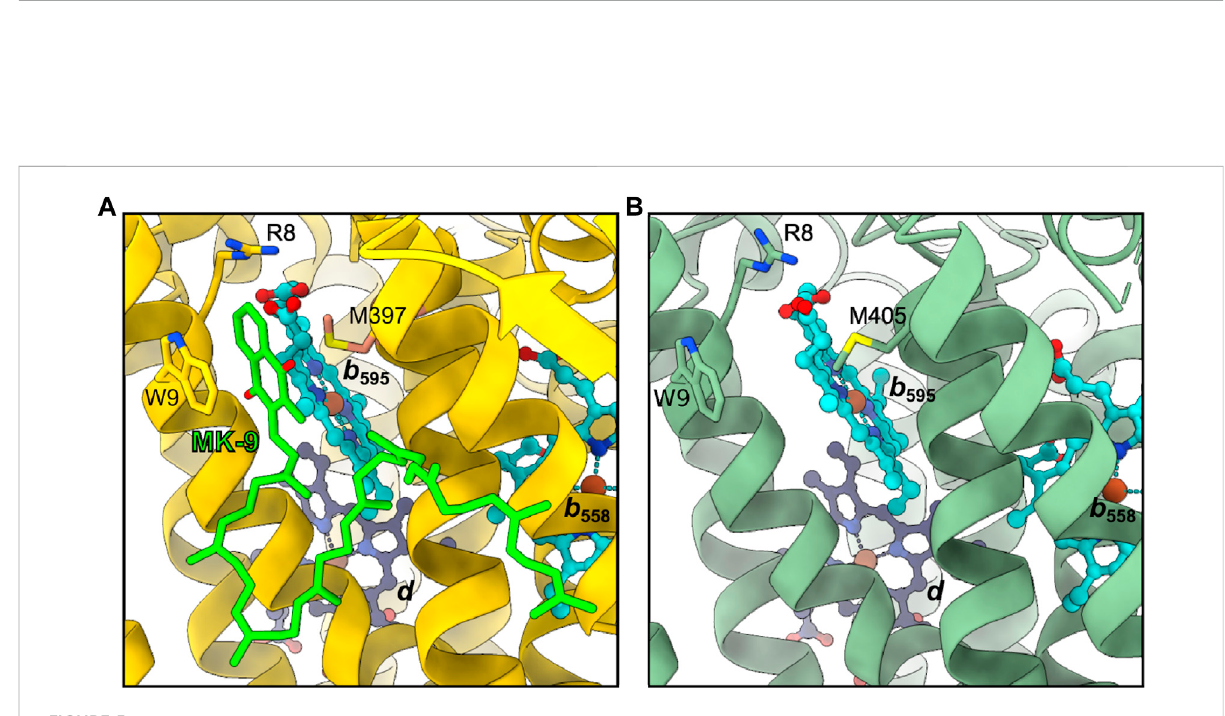
FIGURE 5 Second quinol binding site. (A) In Mtbd , site 2 harbors a bound MK-9 molecule stabilized by W9, R8 and M397. (B) Site 2 appears unoccupied in Cgbd , however the residues interacting with MK-9 in Mtbd are conserved in Cgbd